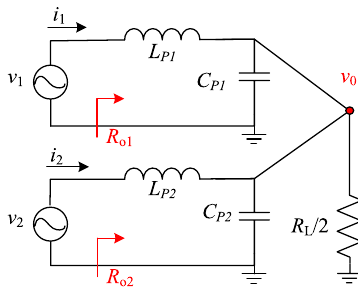
Fig. 3 Parallel combination circuit of two inverter modules